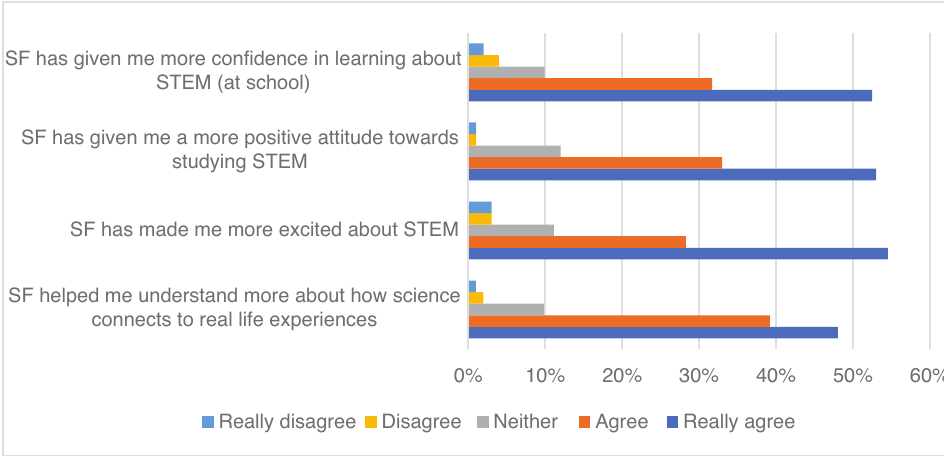
figure 10: child responses about the effect of sMashfestUK (sf) on their attitudes 2018 ( n =102) (simons,